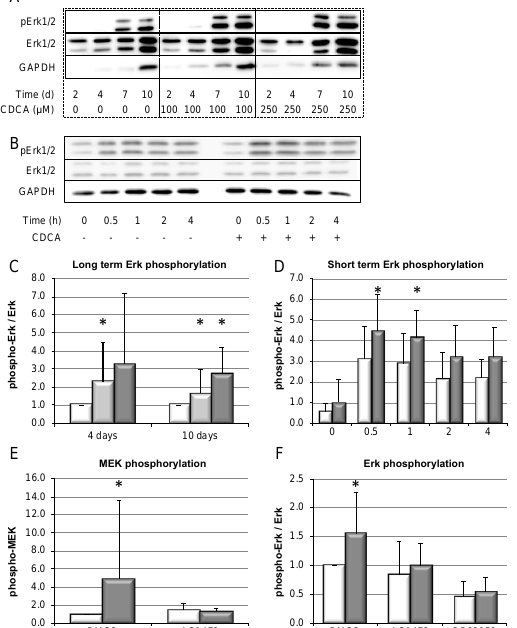
Figure 5. CDCA induces activation of EGFR-, MEK-, and Erk signaling in murine HSCs. HSC were isolated from wild-type mice and stimulated with CDCA for up to 10 days. Activation of Erk was determined by western blotting for phospho-Erk. Representative blots are shown for long-term stimulation with indicated CDCA concentrations ( A ). GAPDH confirmed equal loading for each experimental condition. However, GAPDH expression expectedly changed over time, as HSCs undergo metamorphosis to myofibroblasts during culture, associated with marked metabolic changes. Therefore, total Erk was additionally determined and results are quantified as phospho-Erk/total-Erk. Short-term stimulation with 250 µm CDCA is shown in ( B ), again using total Erk for quantification and providing GAPDH as loading control. Quantification of the results is shown in ( C ) and ( D ) for 100 µm CDCA (light grey bars), 250 µM CDCA (dark grey bars), or DMSO as control (white bars). Furthermore, HSCs were stimulated with CDCA (100 µM, grey bars) compared to control (white bars) for 2–4 h, and inhibitors of EGFR (AG1478, 10 µM) and MEK (PD98059, 50 µM) were added as indicated and compared to control (DMSO). Phosphorylation of MEK ( E ) and Erk ( F ) was quantified and normalized to control. Results are shown as mean ± standard deviation (n = 6–8, * p < 0.05 compared to control, Mann–Whitney U test).